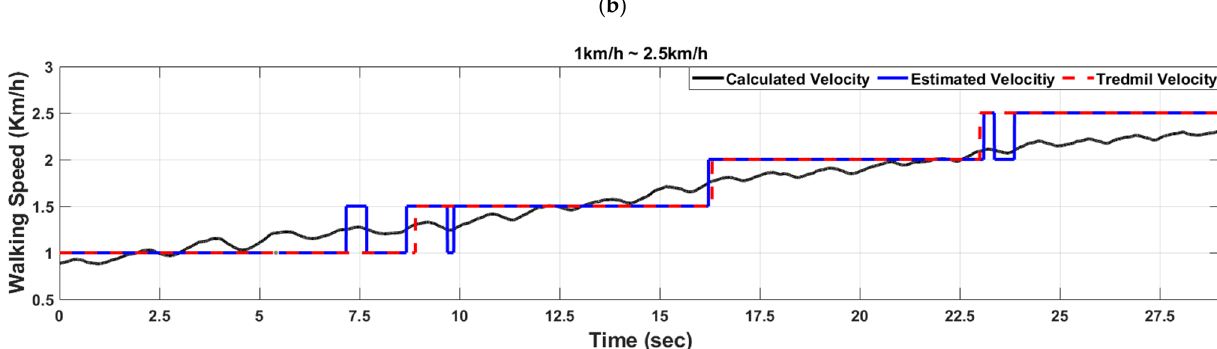
Table 9. The mean absolute error (MAE) and standard deviation (SD) of the angle estimation error according to the walking speed change.